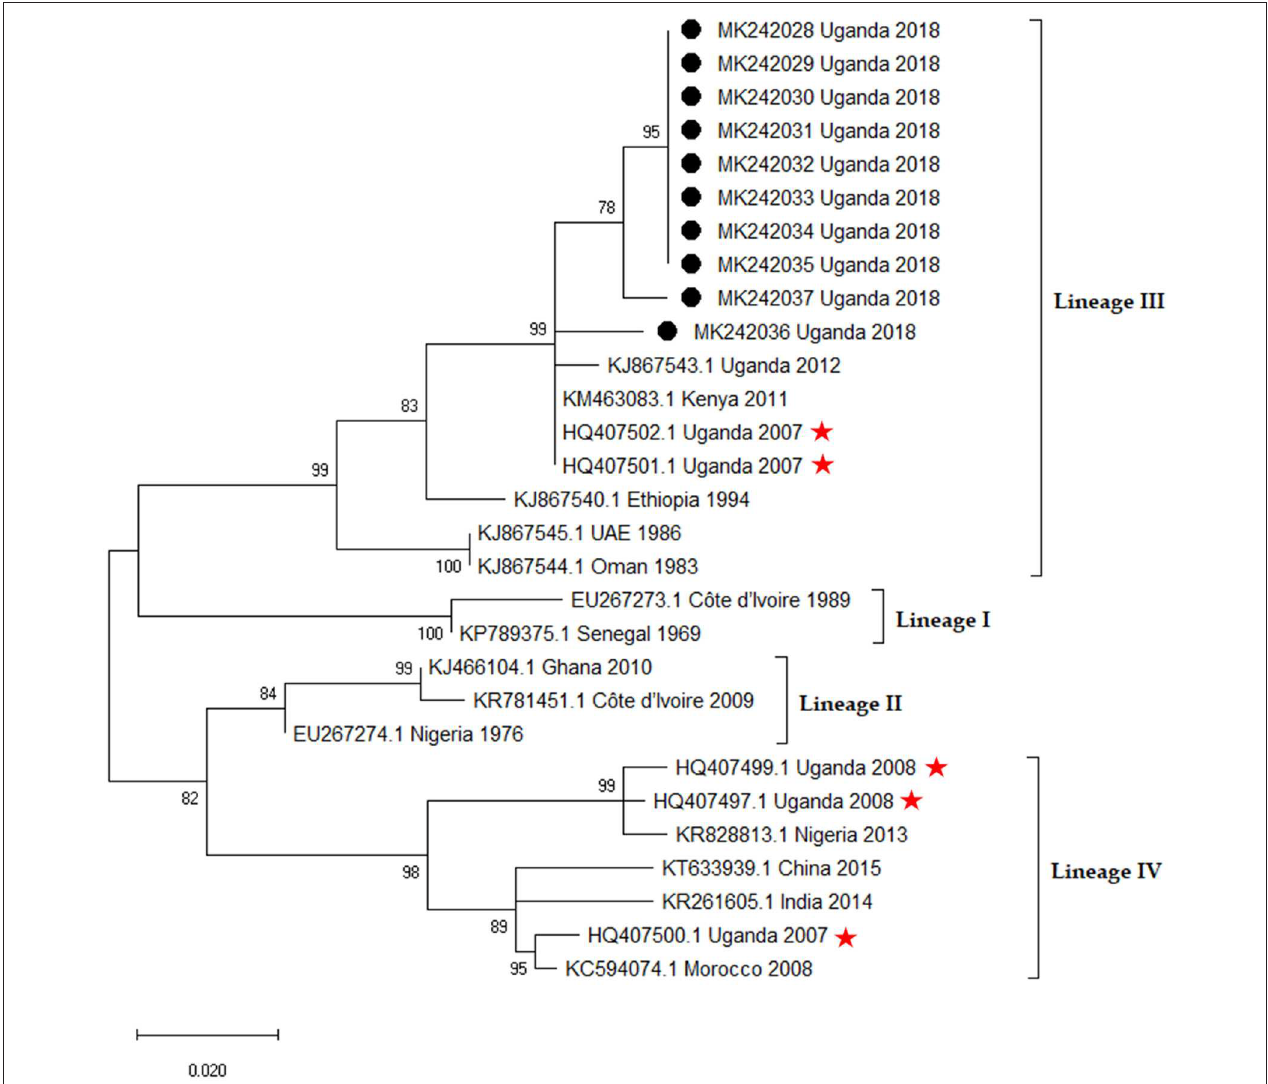
FIGURE 10 | Phylogenetic analysis of Peste des petits Ruminants virus Fusion (F) gene fragment in MEGA X software. The Maximum Likelihood method employing the Kimura 2-parameter ( + I) was selected as the best model to infer evolutionary relationship. The tree is drawn to scale, and the branch lengths correspond to the number of nucleotide substitutions per site. Bootstrap values of 1,000 replicates are indicated at each node. The rate variation model allowed for some sites to be evolutionarily invariable ([ + I], 36.89% sites). This analysis involved 29 nucleotide sequences and their accession numbers, country of origin and year of isolation are indicated. The sequences from this study are denoted by black circles [ • ] and sequences with asterisks [ ] are the ones misclassified by Luka et al. (20).